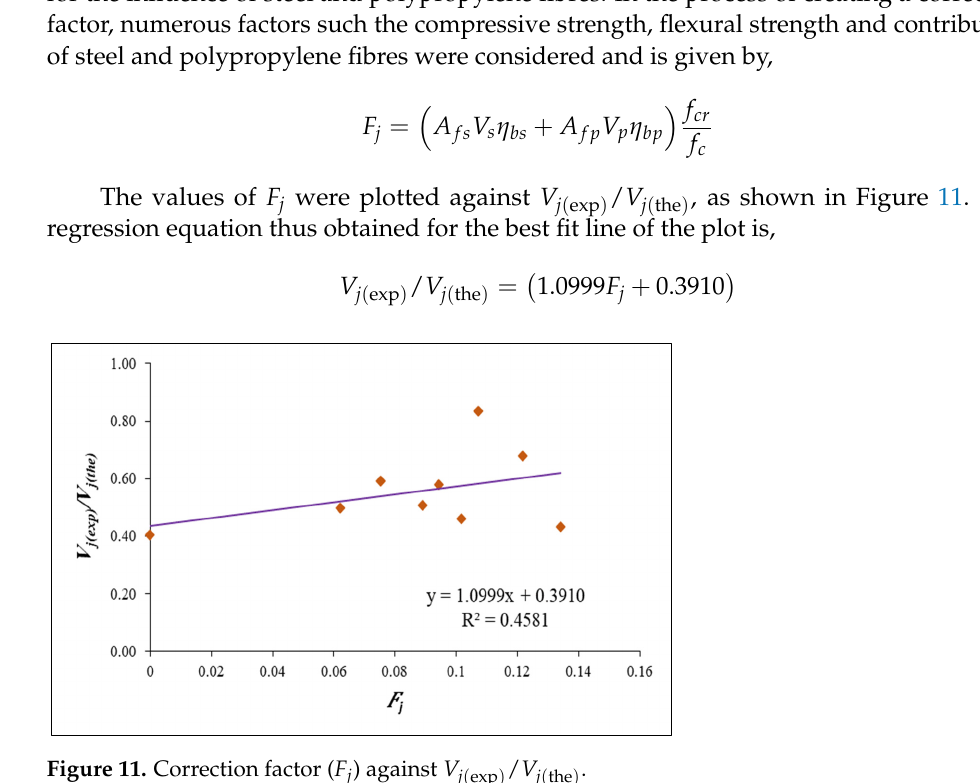
j ) against V j ( exp ) / V j ( the ) .